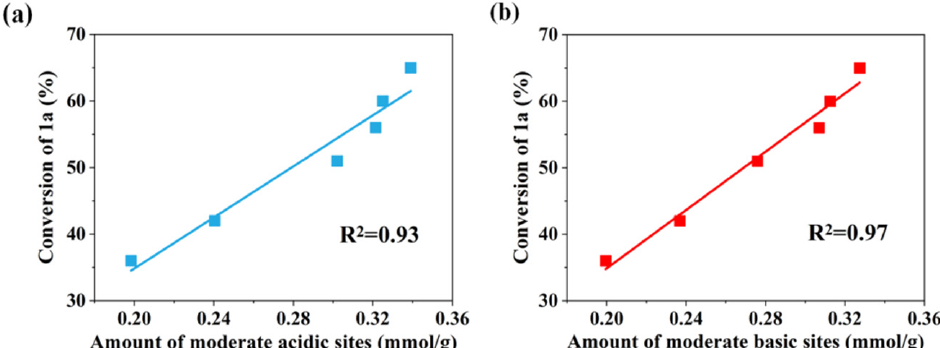
Figure 5. Correlation between the conversion of 1a and number of active sites: ( a ) moderate acidic sites, ( b ) moderate basic sites.